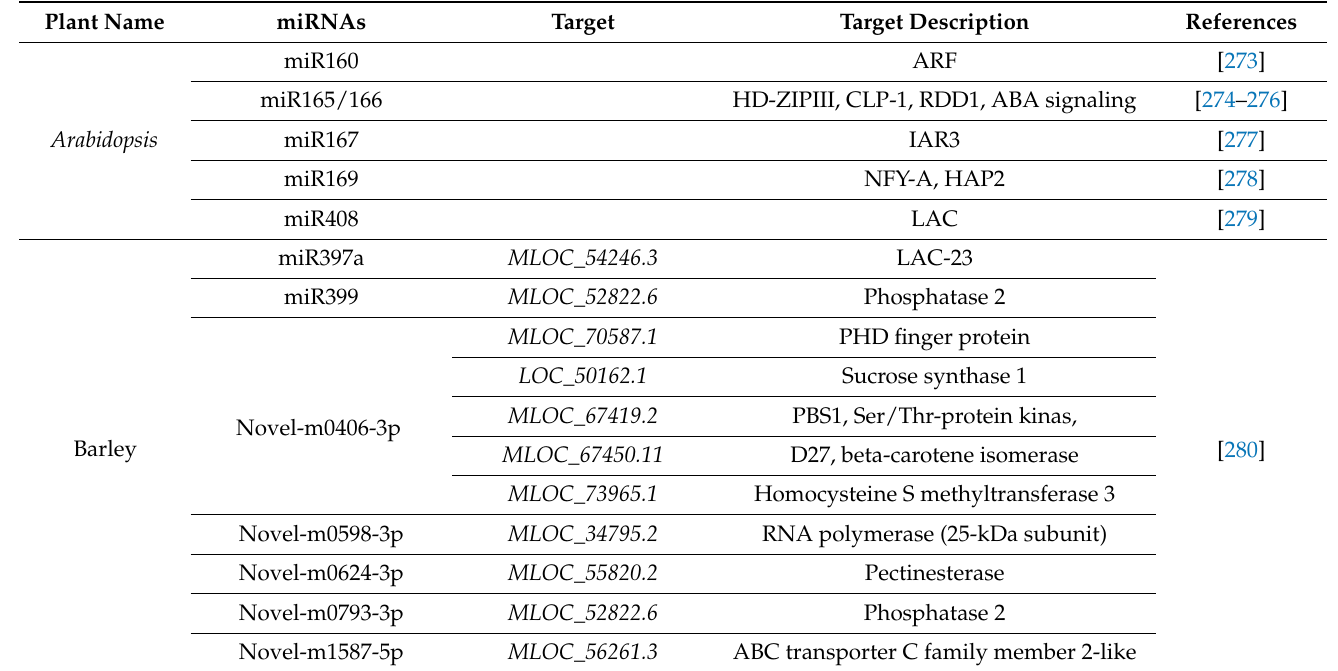
Table 4. Drought-responsive miRNAs reported in different crop